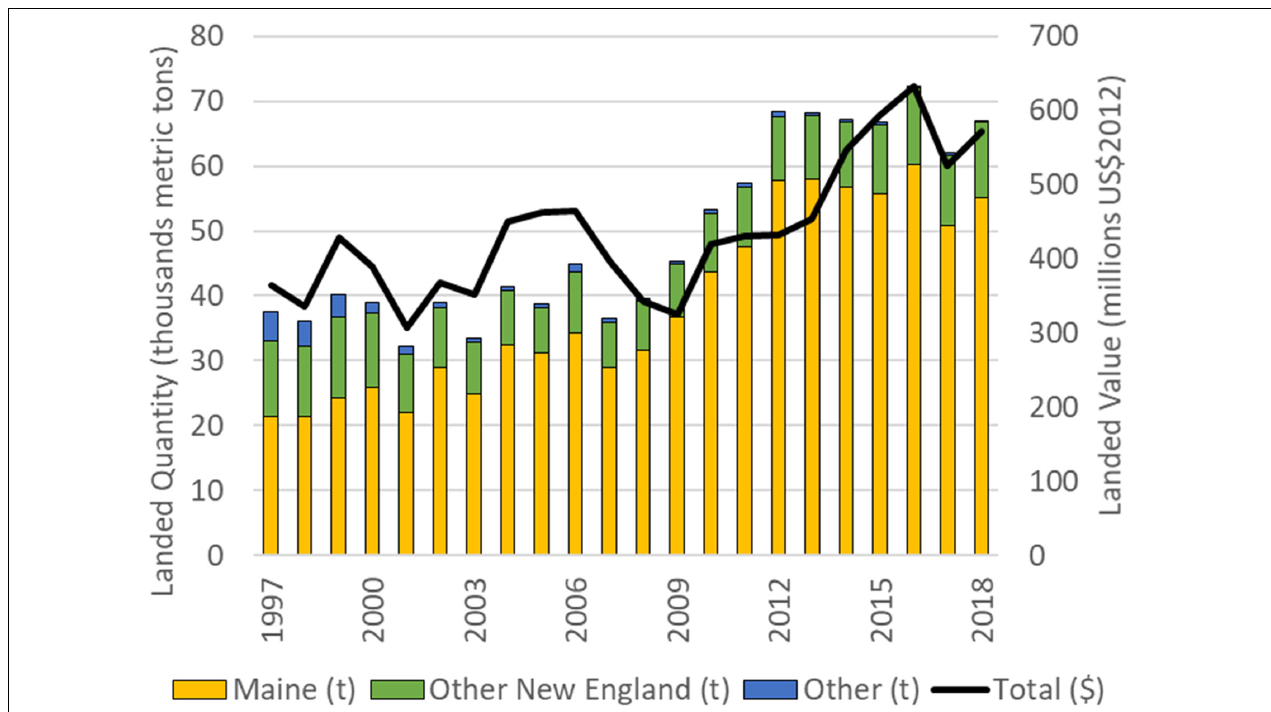
FIGURE 1 | United States Lobster ( Homarus americanus ) landings for Maine (stacked yellow column), other New England states (stacked green column) and the rest of the United States (stacked blue bar) in thousands of metric tons and total landed value (solid line, right axis) in millions of United States dollars (US$2012), 1997–2018. New England coastal states include Maine, New Hampshire, Massachusetts, Rhode Island, and Connecticut. Source: NOAA Fisheries. Commercial Fisheries Statistics. https://www.fisheries.noaa.gov/national/sustainable-fisheries/commercial-fisheries-landings.